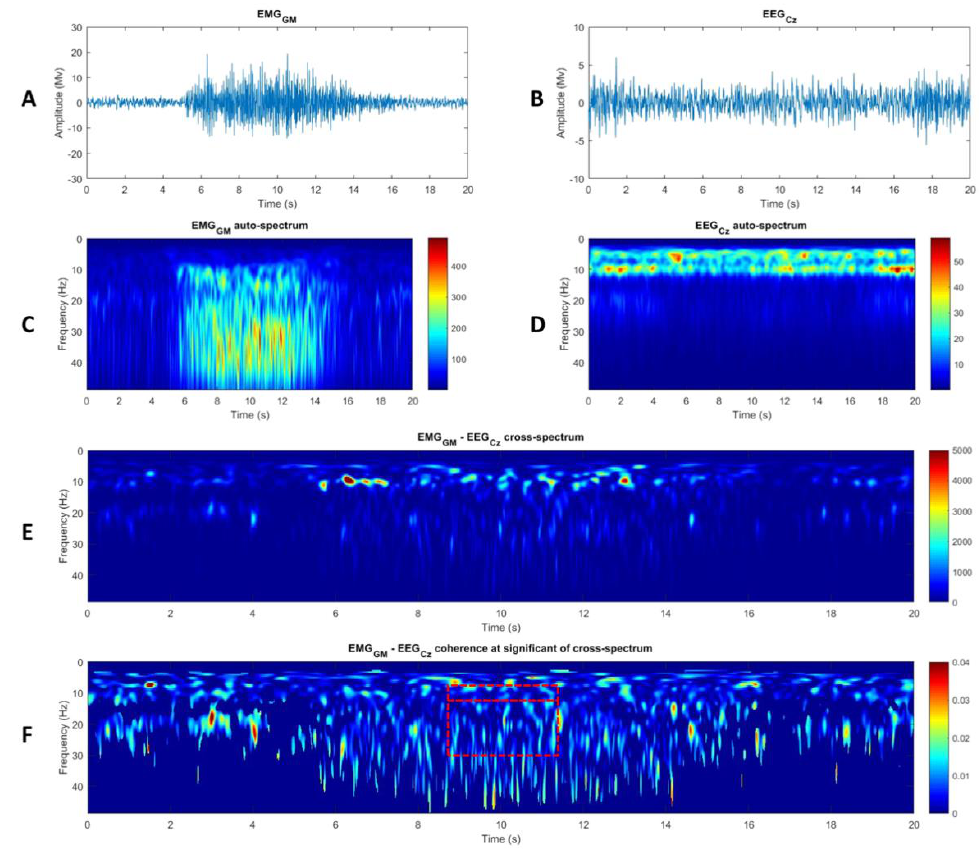
Figure 2. Typical recording of ( A ) Gastrocnémius Medialis (GM) electromyographic (EMG) and ( B ) Cz electroencephalographic (EEG) activities obtained during the experimental procedure. Wavelet auto-spectra of the GM EMG ( C ) and Cz EEG ( D ) signals. ( E ) Wavelet cross-spectrum and ( F ) wavelet-magnitude squared coherence between GM EMG and Cz EEG signals in the time-frequency domain. The red rectangles delimit the α (8–13 Hz) and ß (13–31 Hz) frequency band over the period of interest.